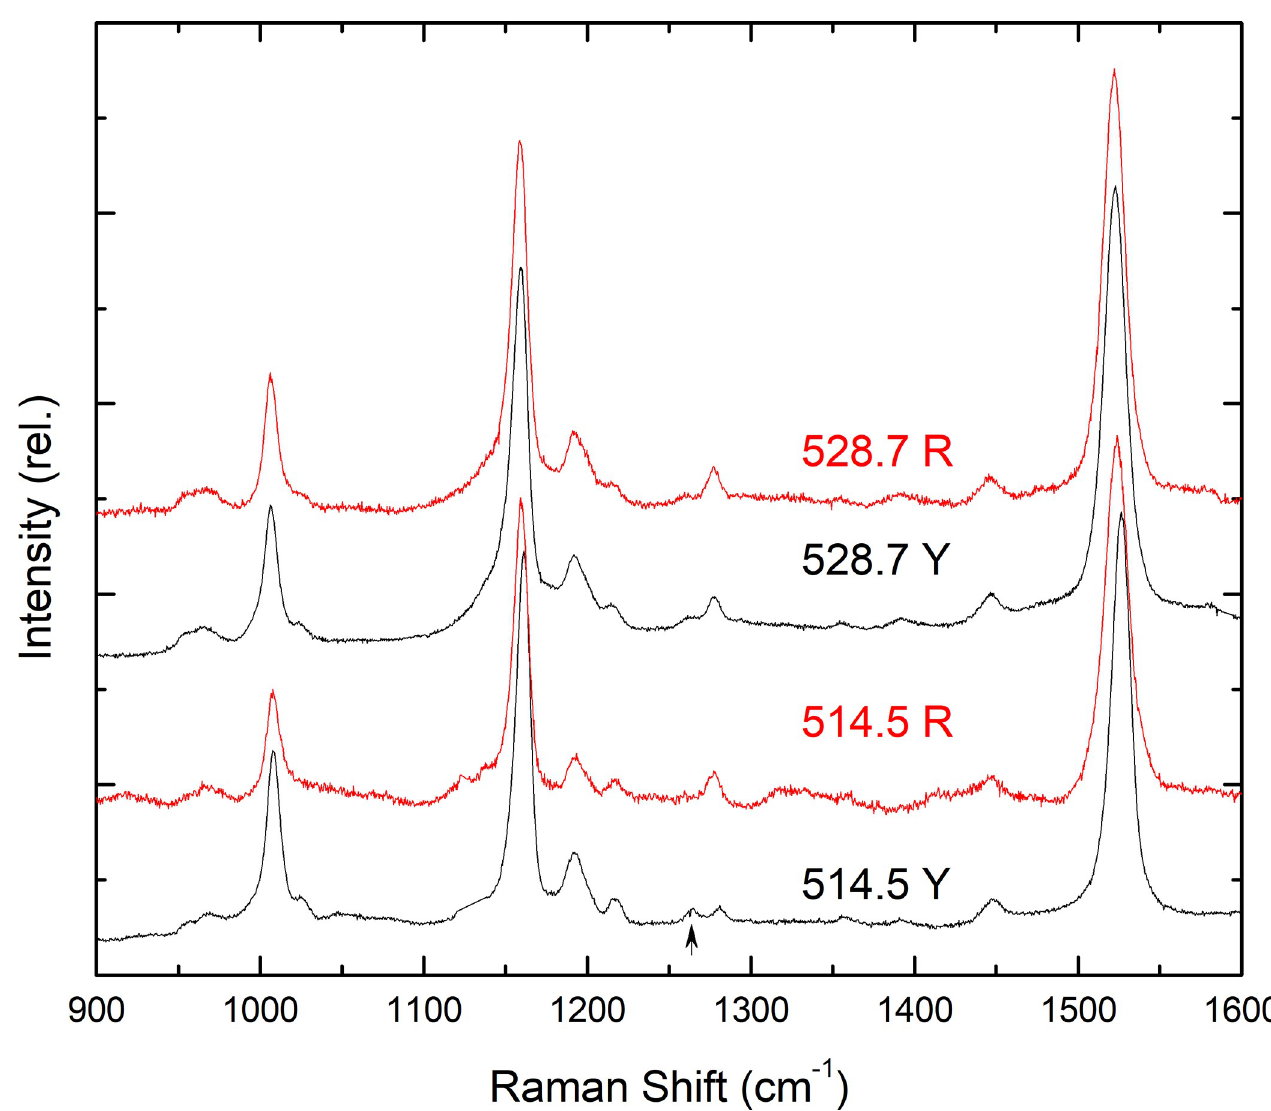
Fig 4. Resonance Raman spectra of R & Y droplets at 110 K, excited at 528.7 & 514.5